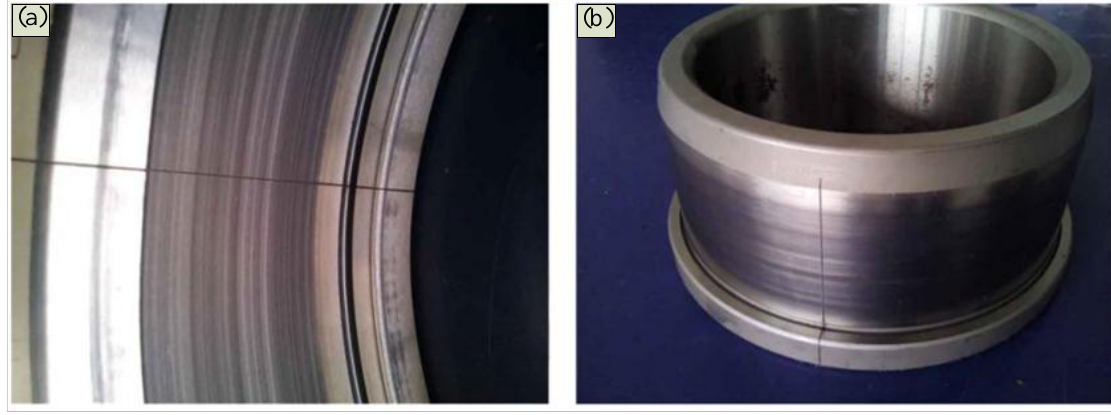
Figure 16. Artificial defects on the components of the bearing ( a ) defect on the outer race and ( b ) defect on the inner